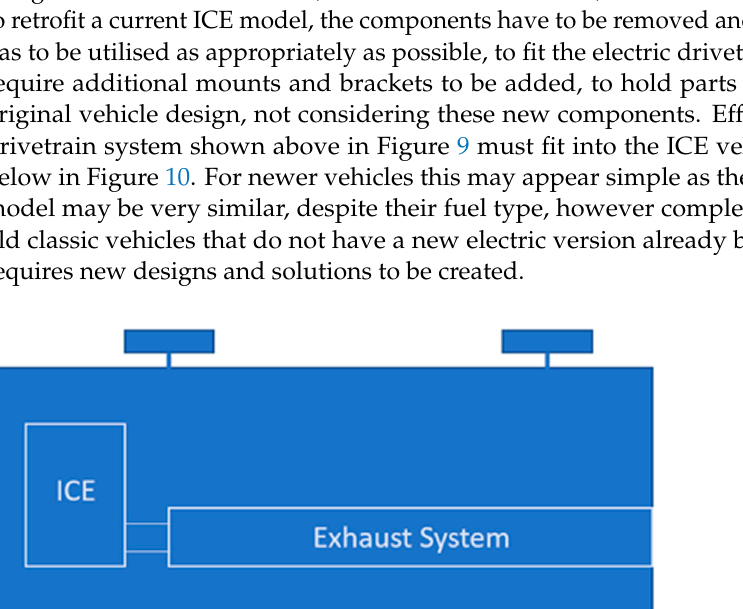
Figure 10. Basic layout of an ICE vehicle, highlighting the engine and exhaust system.